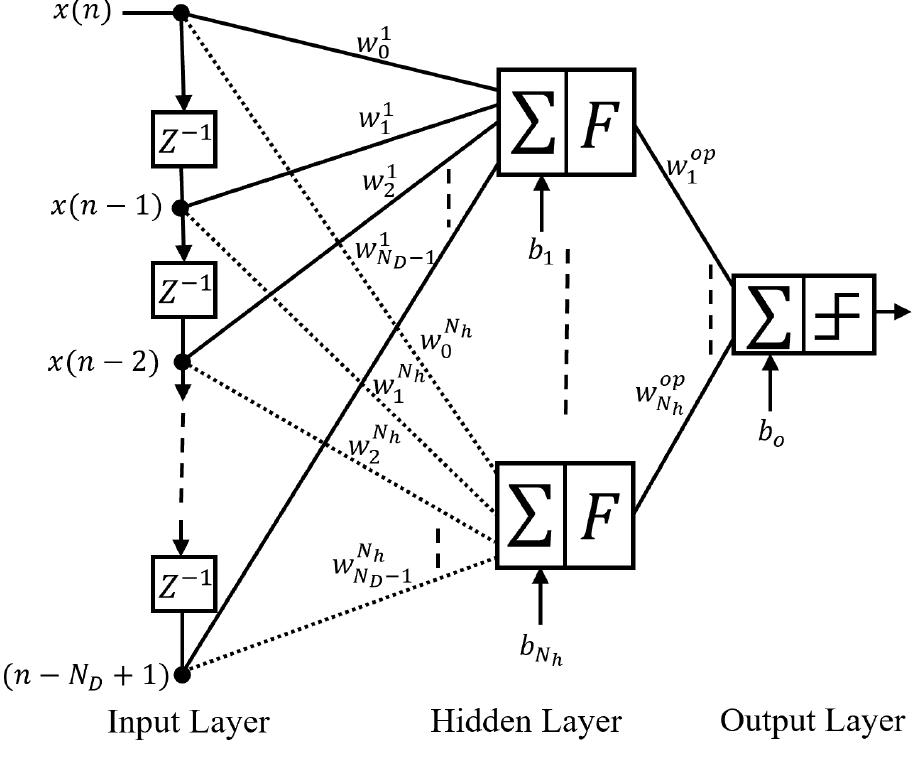
Figure 2. Proposed TDNN architecture for LAA